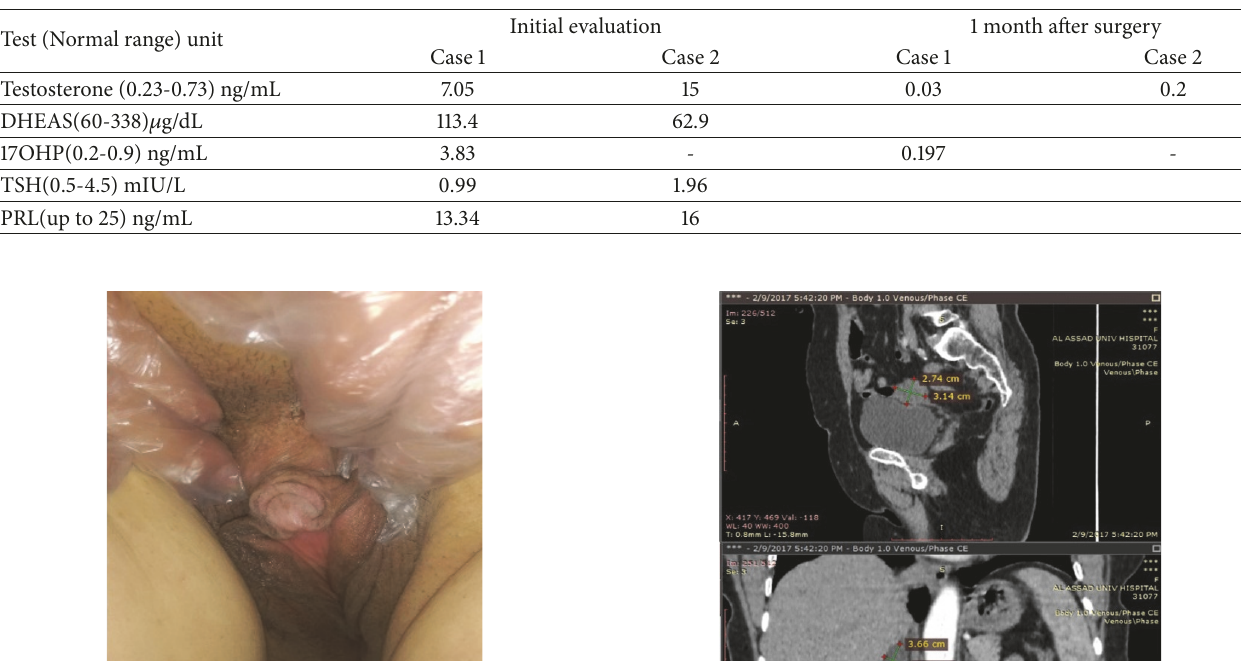
Table 1: Hormonal study at initial assessment and normalization of androgens one-month postsurgery.